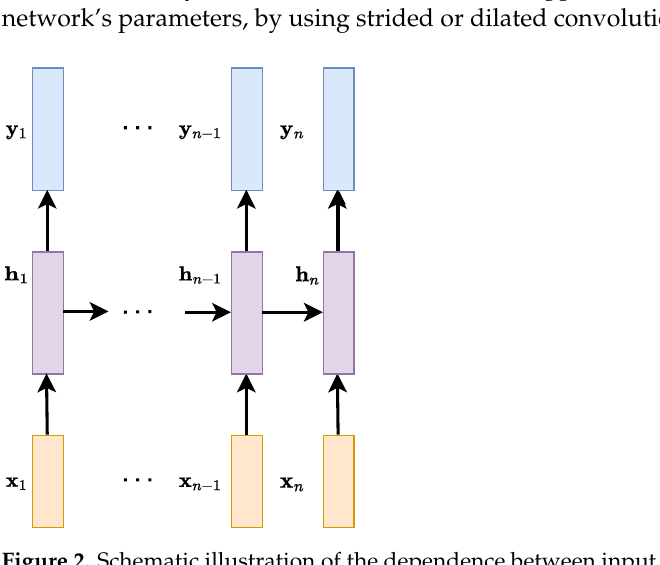
Figure 2. Schematic illustration of the dependence between input vectors ( x 1 , . . . , x n ), state vectors ( h 1 , . . . , h n ), and output vectors ( y 1 , . . . , y n ) in the RNN